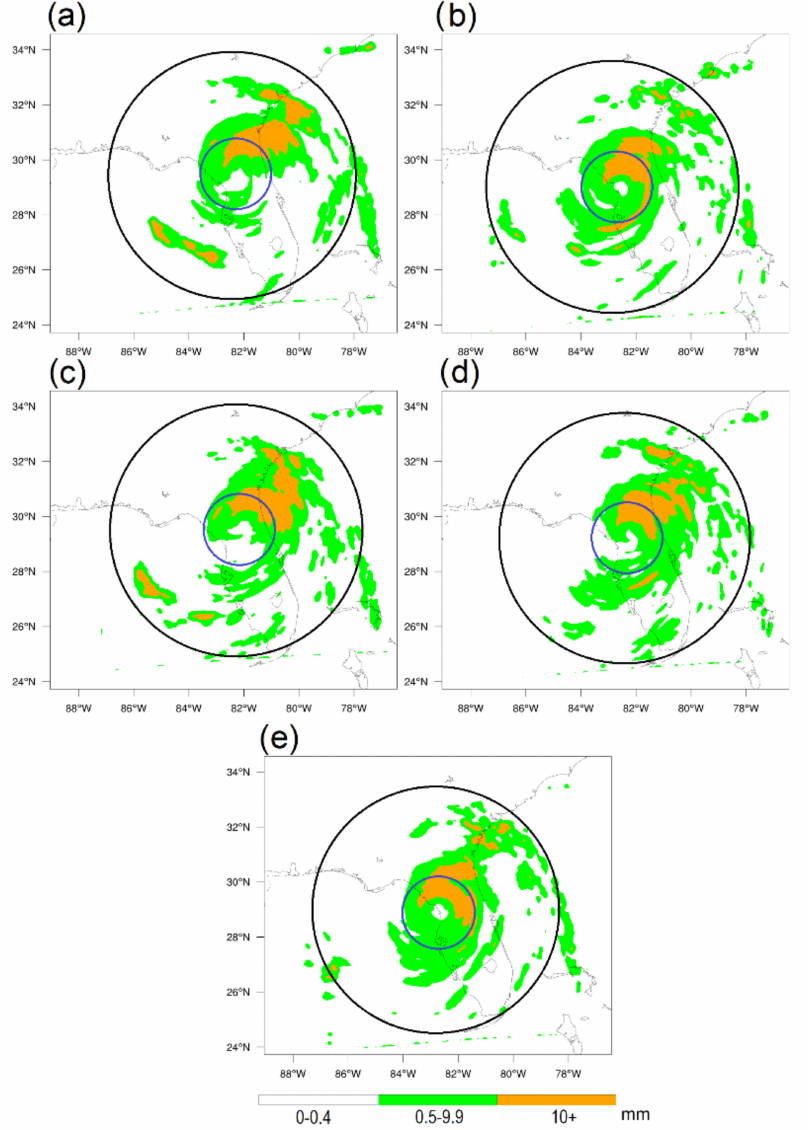
Figure 8. Accumulated-precipitation between 1100 UTC to 1200 UTC 26 August, with black circle indicating 500 km radius and blue circle indicating 150 km radius for ( a ) DS Case; ( b ) WS Case; ( c ) DR Case; ( d ) WR Case; and ( e ) Control Case. Circle is centered at the storm location at 1130 UTC 26